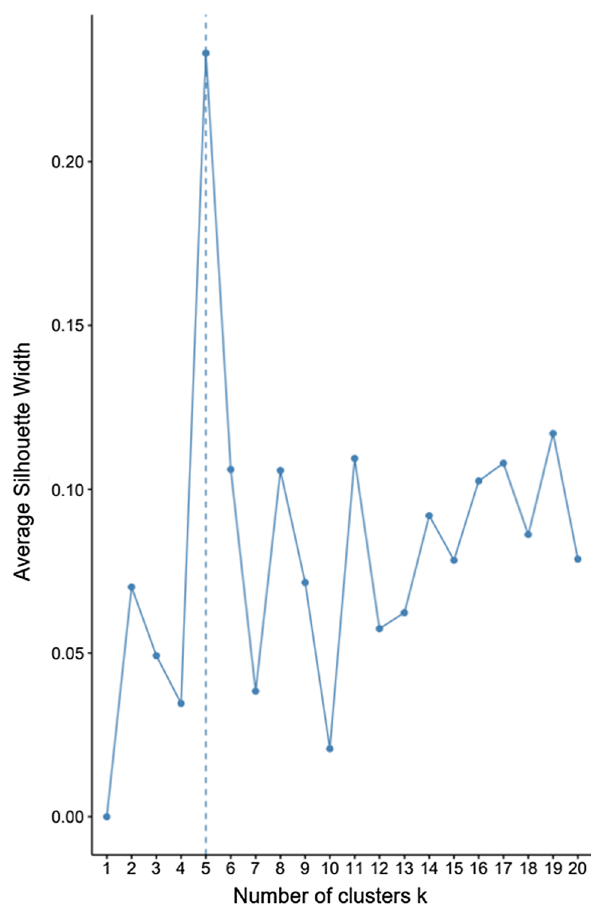
Fig. 3 Output of the silhou- ette method to determine the proper number of clusters to be generated. The method indicated five clusters as appropriate for the IoT tweets